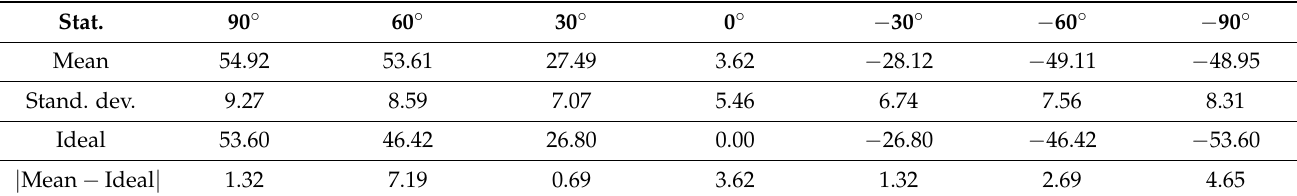
Table 3. Statistics for measured time delays for receiver device angles.